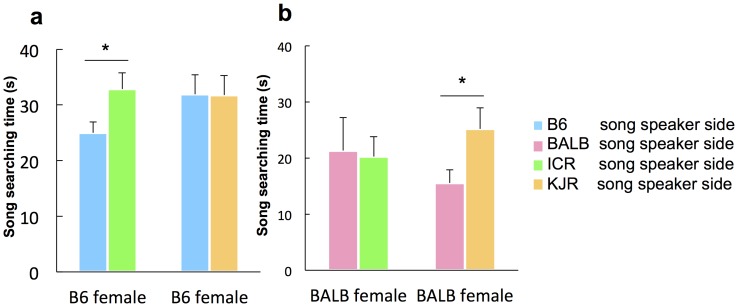
Female song searching response to playback with KJR and ICR strain male song.(a) When B6 and ICR male songs were presented, ESP1-treated B6 females showed longer search times for ICR songs than for B6 songs (n = 13), whereas there was no difference in search time when B6 and KJR male songs were presented (n = 12). (b) When BALB and KJR male songs were presented, ESP1-treated BALB females showed longer search times for KJR songs than for BALB songs (n = 12), whereas there was no difference when BALB and ICR male songs were presented (n = 11). Values represent means+standard error. Asterisks indicate significant differences p<0.05.